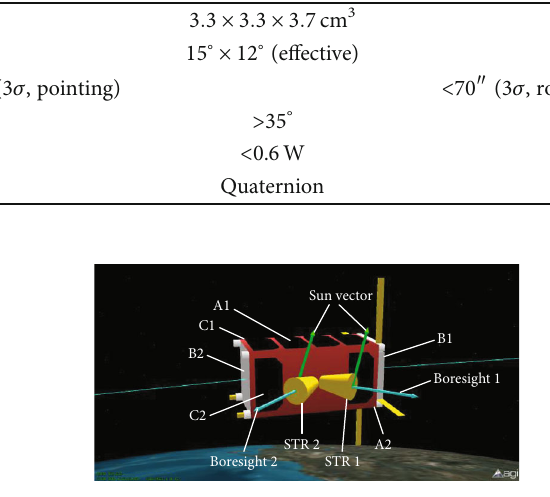
Figure 1: On-orbit fl ight model of CubeSat in STK.